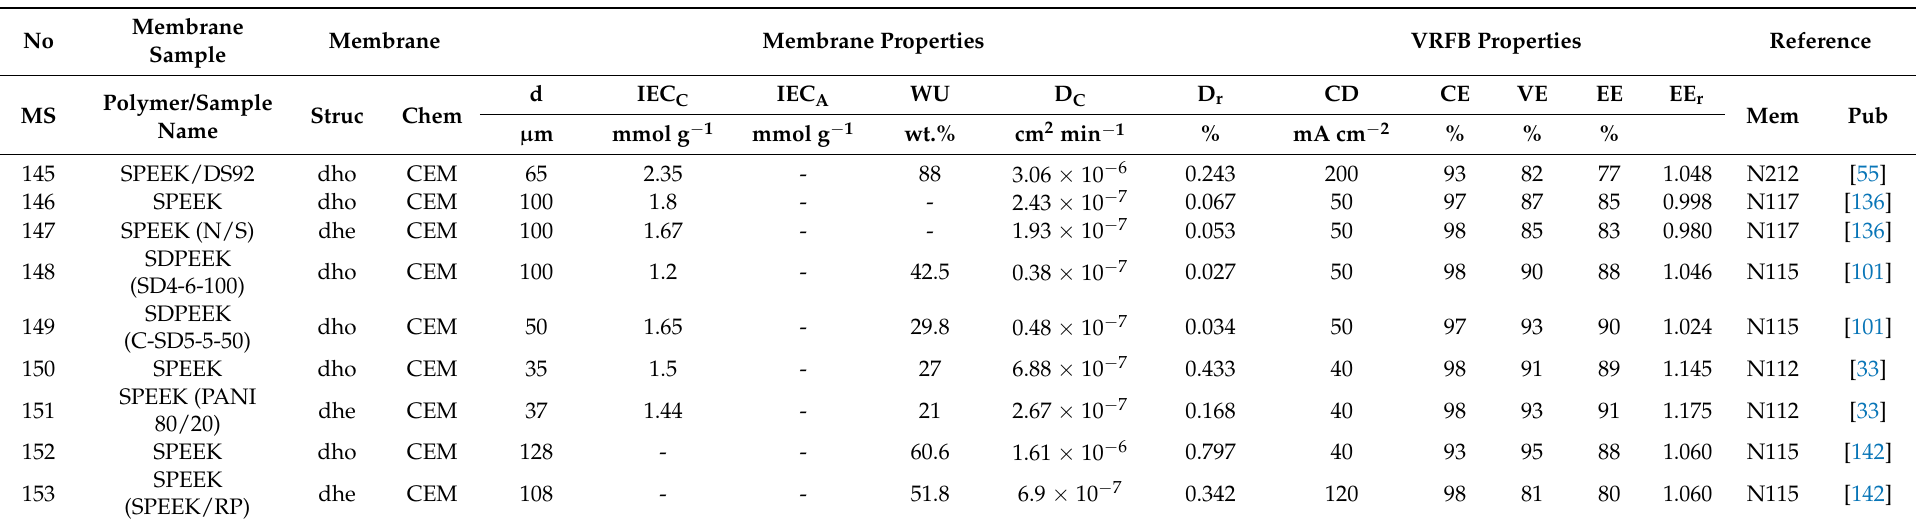
Table 7. List of ether-ketone-based hydro-carbon membrane